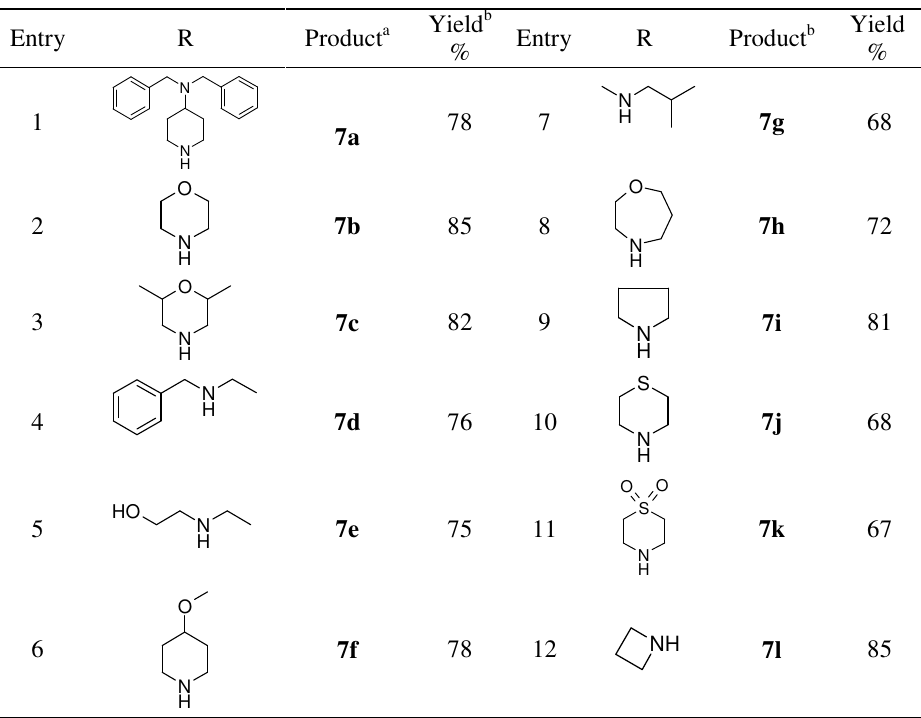
Table 1. Synthesis of N -methyl